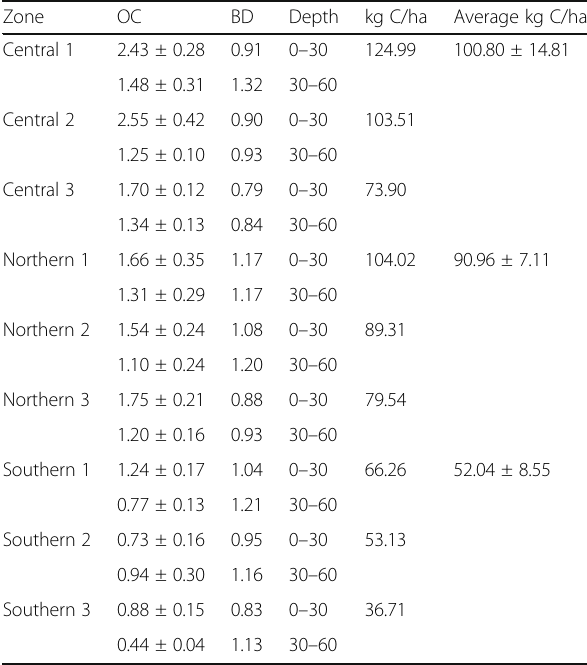
Table 1 Zone-wise height and GBH